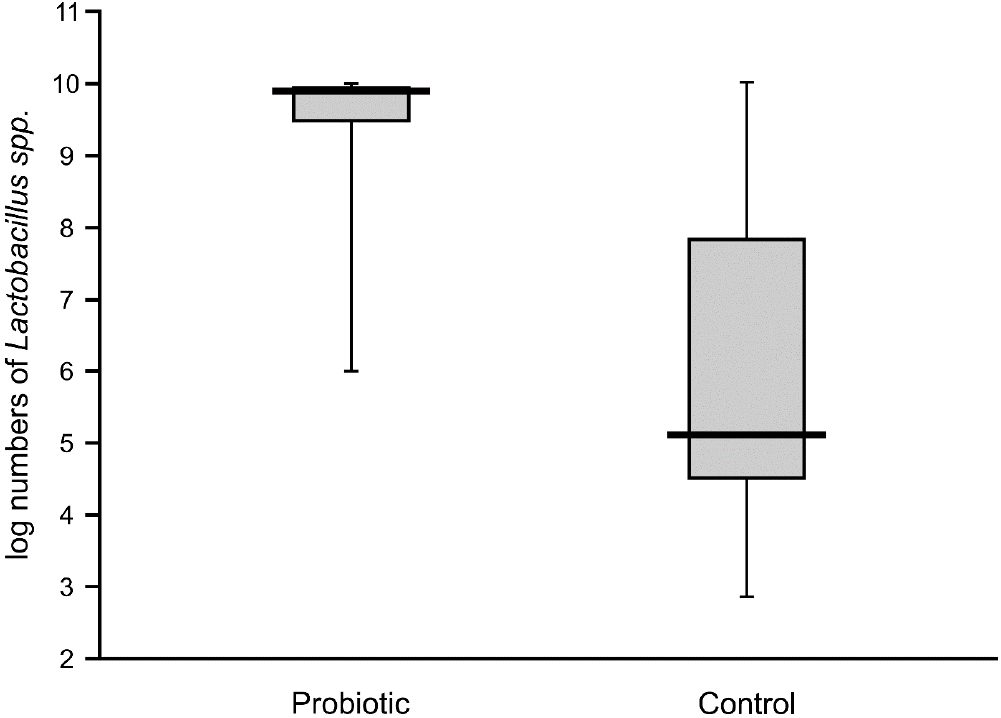
Figure 4. Abundance of lactobacilli in feces obtained from the second sampling of neonates supplemented with probiotics vs. controls (Mann–Whitney test, Z = 8.48069; p < 0.00001).